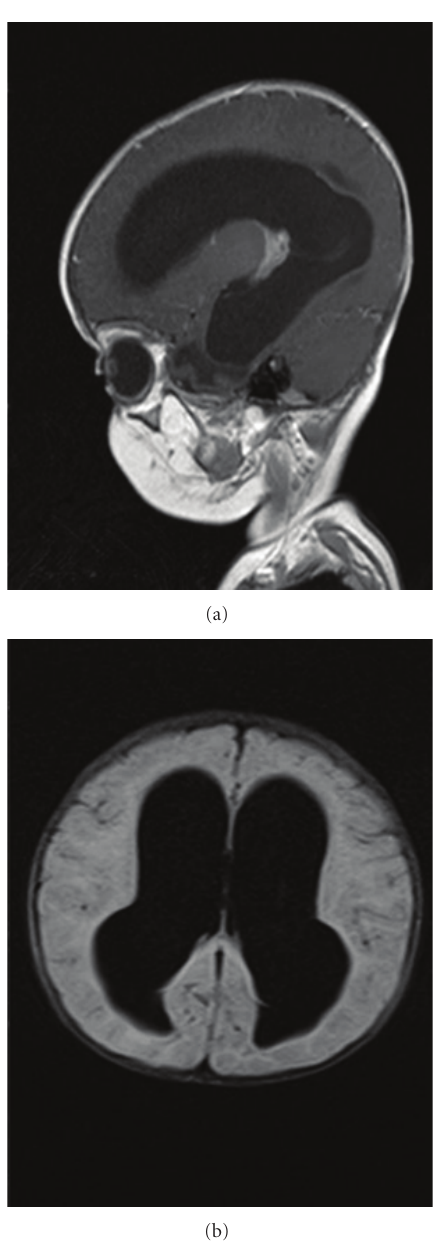
Figure 1: T1 sagittal (a) and T2 dark fluid transverse (b) view of brain MRI show